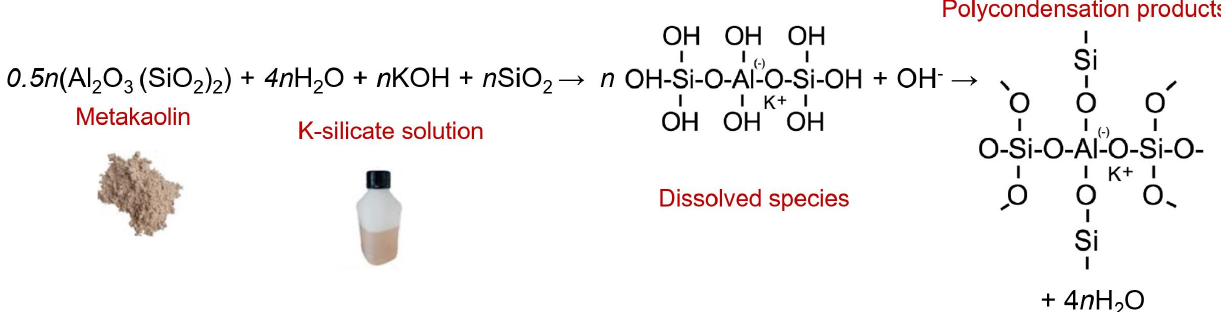
Figure 1. A scheme of geopolymerisation reaction mechanism.